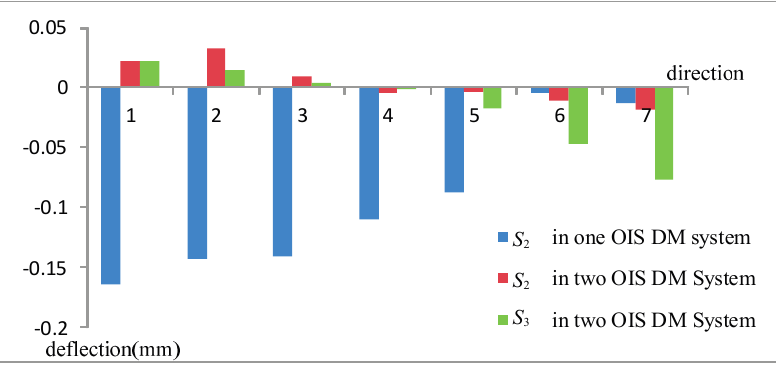
Figure 5. Deflections of the surface at the DM center point for the variations along seven directions, with different colors for the corresponding